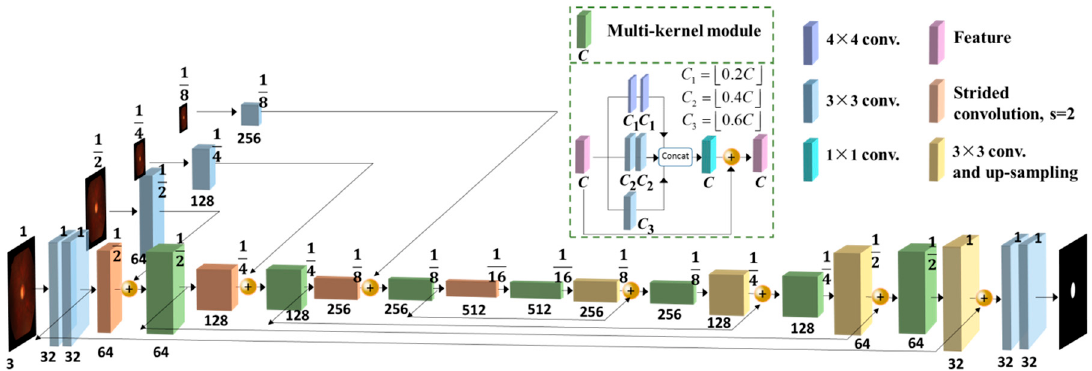
Figure 4. The structure of the U-shaped convolutional neural network with multi-kernel